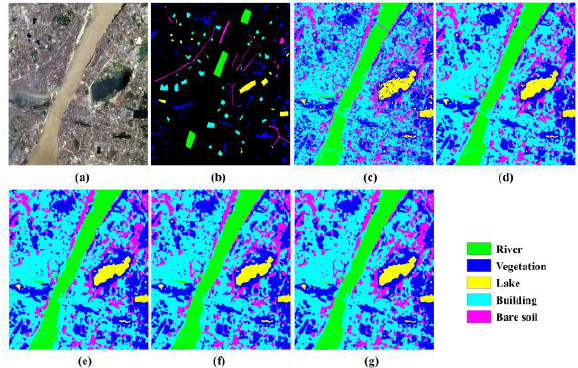
Figure 6. WuhanTM image and its classification results: (a) true color composite of the WuhanTM image; (b) reference map; (c) OCM; (d) CM_Distance; (e) CM_Eastman’s U; (f) CM_Entropy; (g)